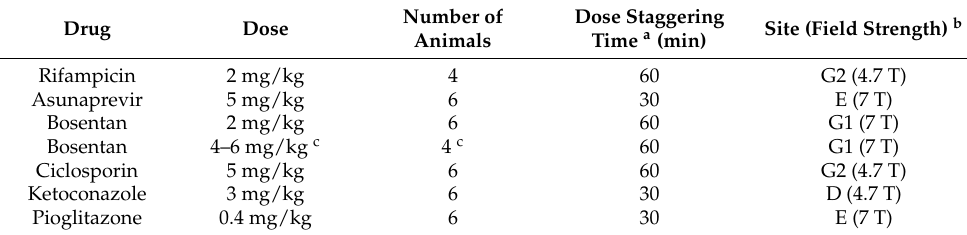
Number of Dose Staggering Site (Field Strength) b Animals Time a (min)